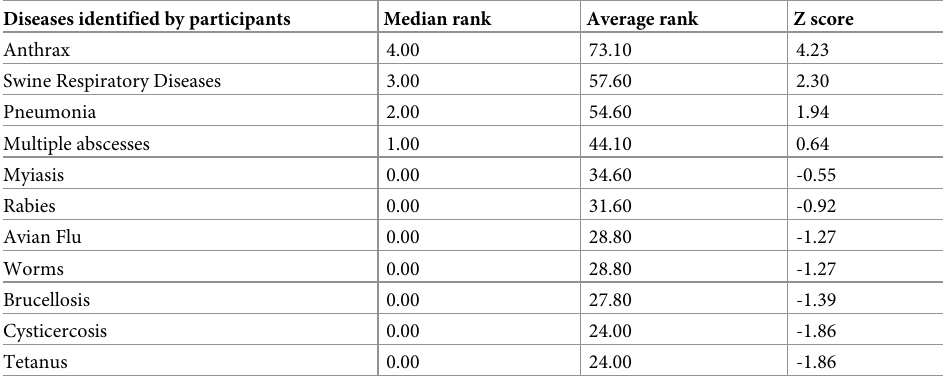
Table 1. Zoonotic diseases identified by participants in the focus group discussions, Nakuru, Kenya, 2020. Diseases identified by